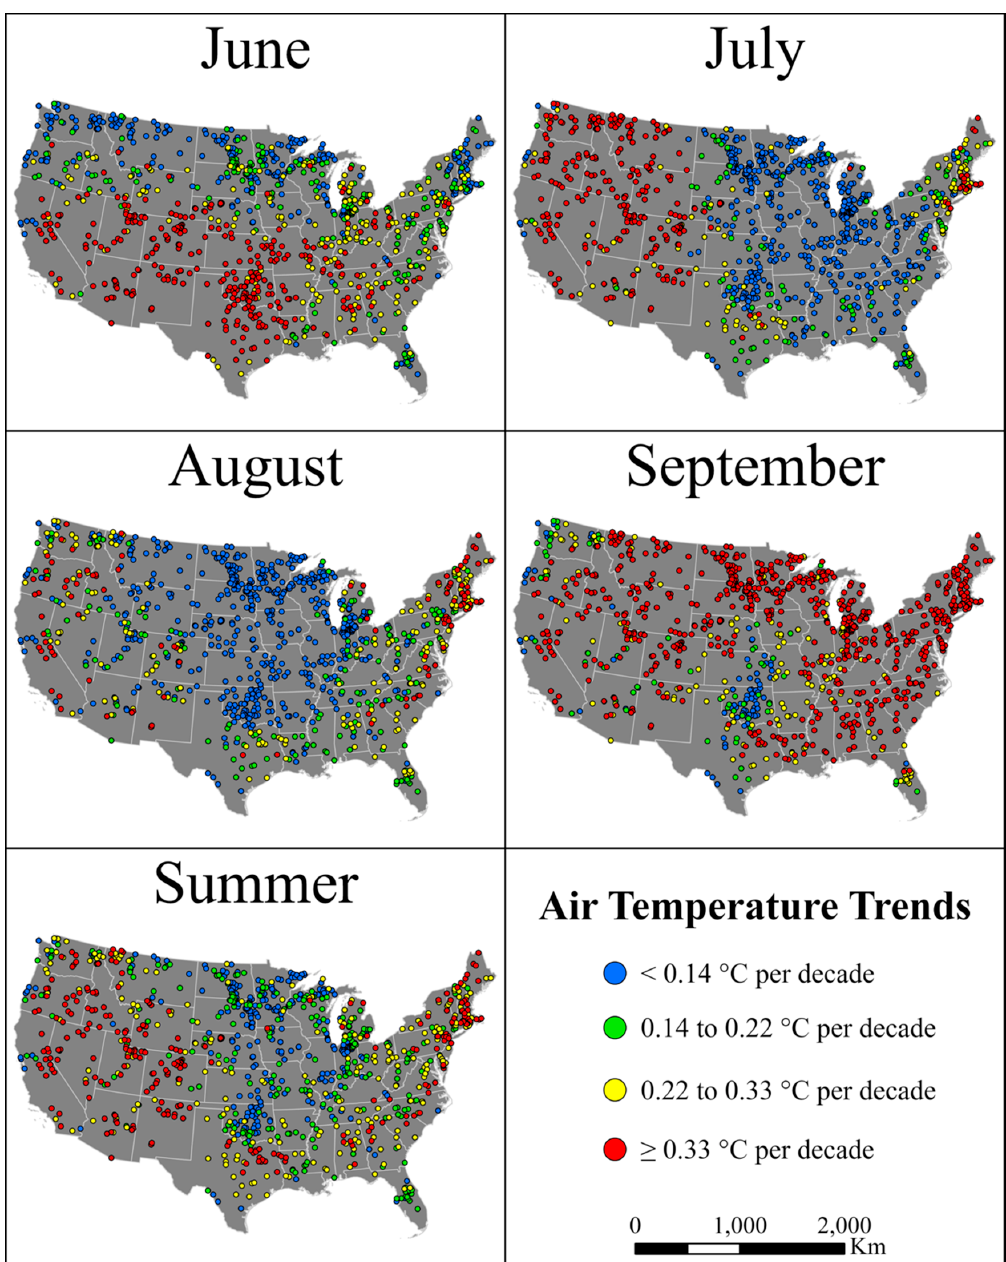
Figure 5. Rates of temperature change in average air temperatures at the locations of 1033 United States lakes during the time period 1981–2018.